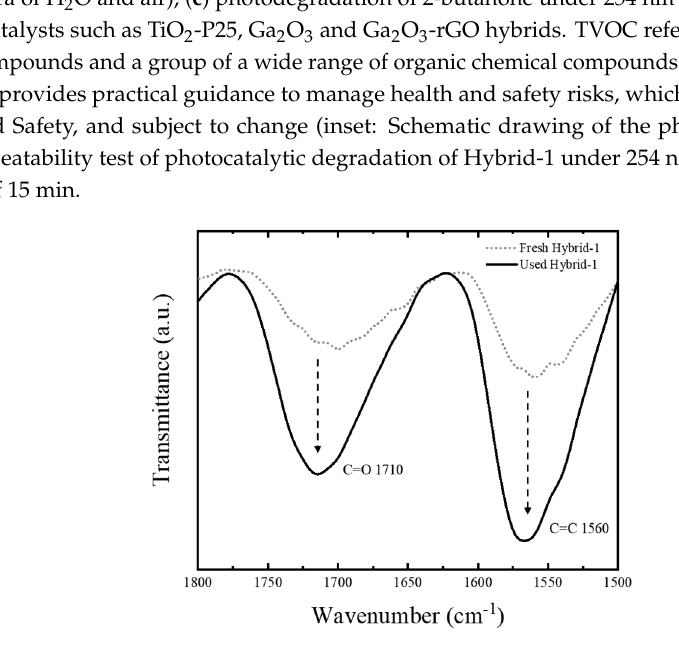
Figure 5. Optical transmittance of fresh Hybrid-1 and used Hybrid-1 as a function of wavelength.